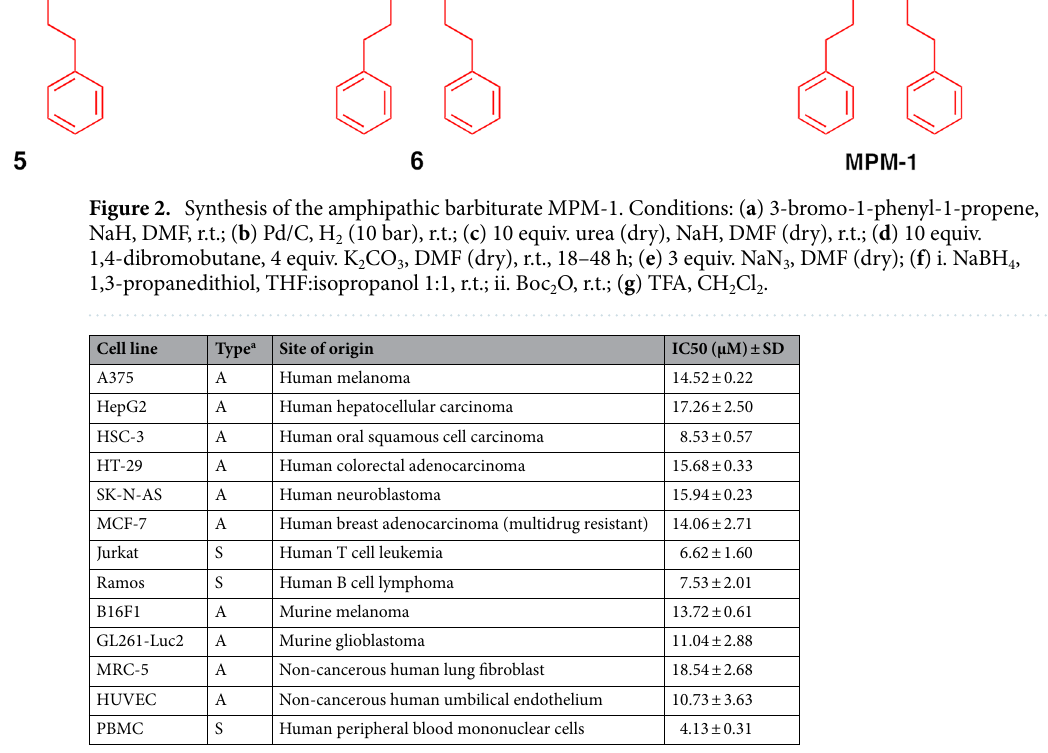
Table 1. MPM-1 IC50 values obtained from MTS cytotoxicity assays after four hours of incubation. The values represent the mean from three independent experiments ± standard deviation. a A = Adherent cells, S = Suspension